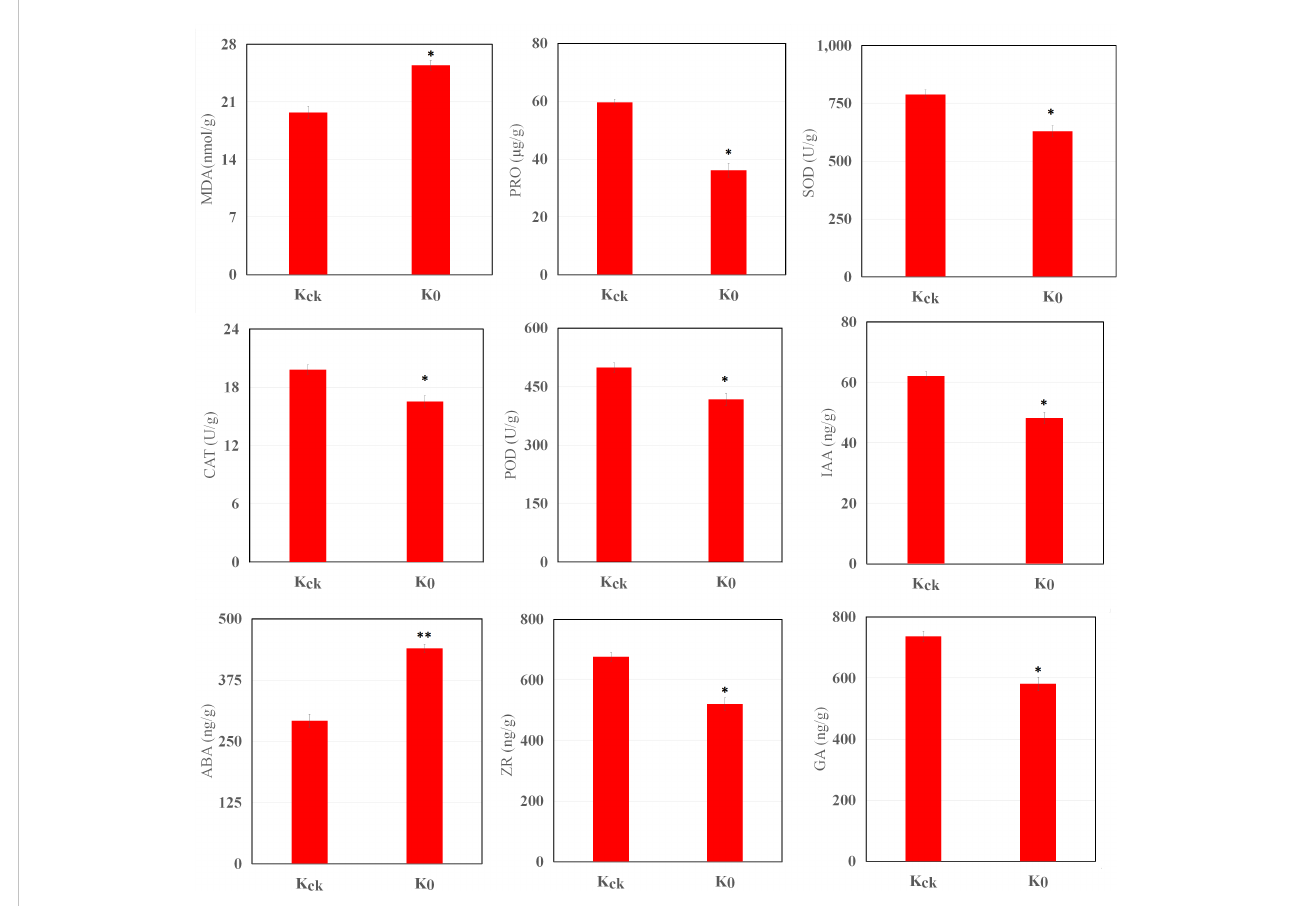
FIGURE 2 MDA, Pro, IAA, GA, ABA, and ZR contents and SOD, CAT, and POD activities in K 0 vs. K ck . * P ≤ 0.05, ** P ≤ 0.01. Bars represent